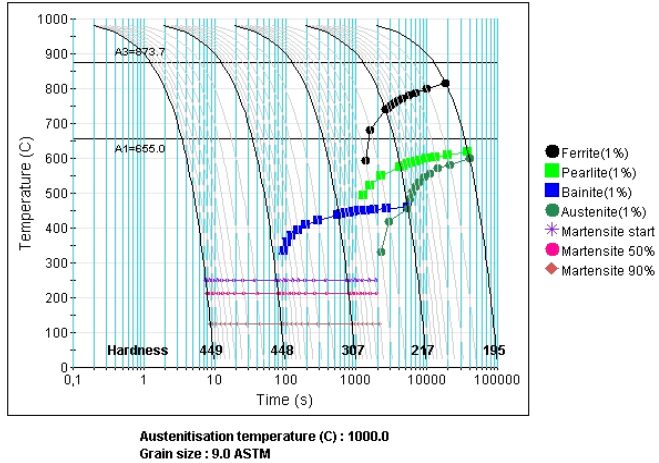
Figure 8. Predicted CCT diagram of 5 Mn steel determined using the JMatPro package.